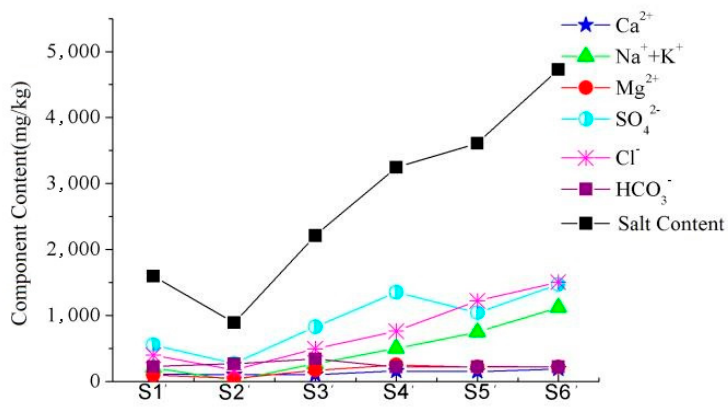
Figure 11. Groundwater component content.